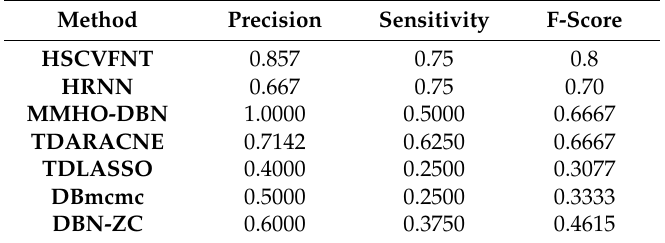
Table 2. Comparison of seven methods for IRMA network inference with on dataset.